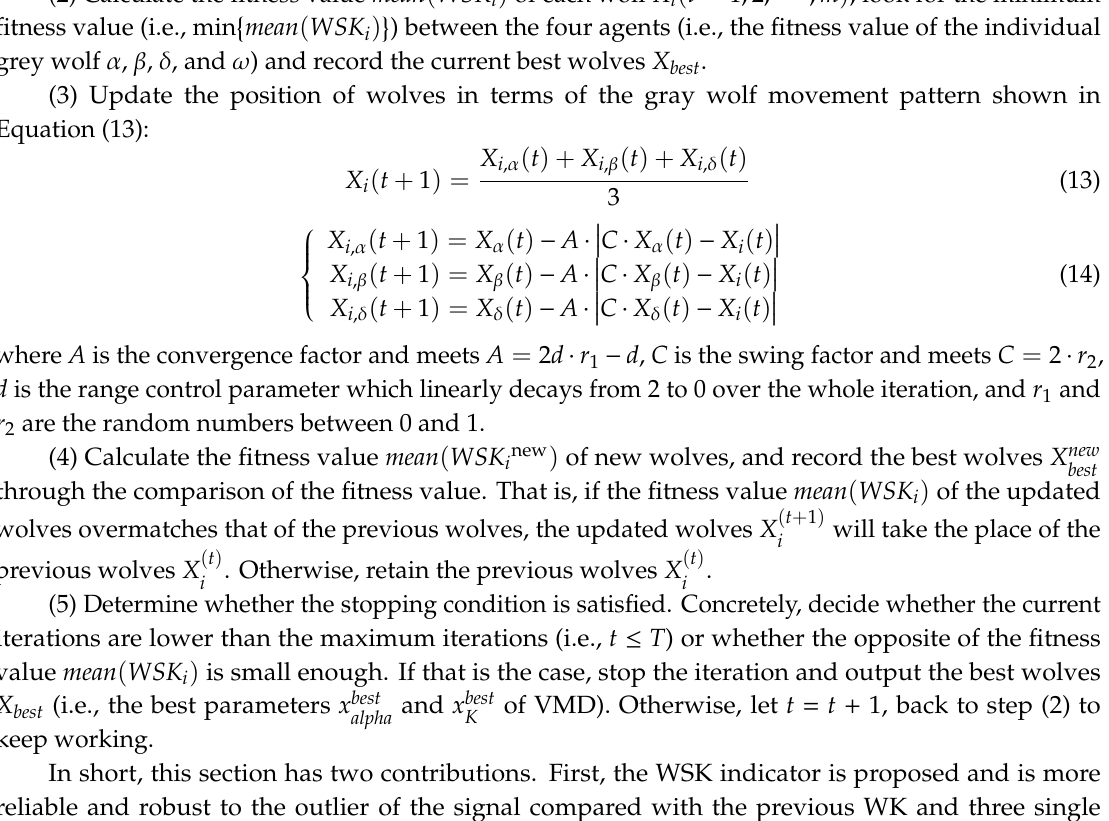
Figure 6. Flowchart of the parameter optimization of VMD using the GWO algorithm. 3.3. Teager Energy Operator For a given continuous-time signal with modulated information